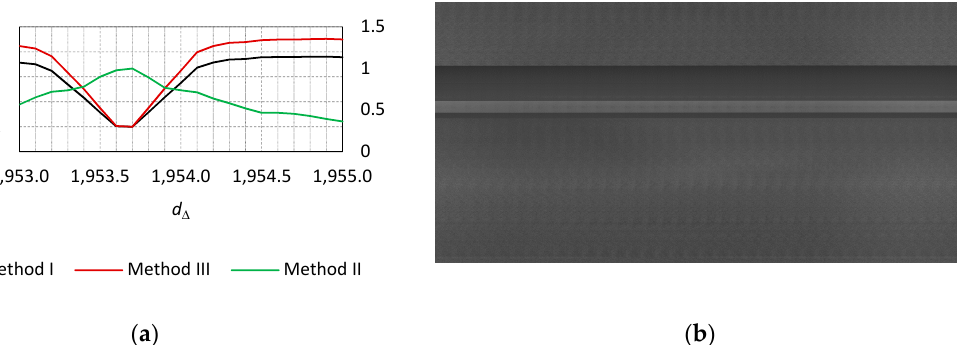
Figure 13. ( a ) The normalized values of the adopted measures (method I, II and III) calculated in domain of image line length d ∆ for the accuracy ∆ = 0.1 (for the original image shown in Figure 7a) and ( b ) image reconstructed on the basis of the recorded revealing emission signal at frequency f o = 1334 MHz (receiving bandwidth BW = 50 MHz) for estimated line length d ∆ = 1953.70000 (accuracy ∆ = 0.1)—multiple of image summation Sum MTL = 30, the source of revealing signal emission—display monitor, HDMI standard.